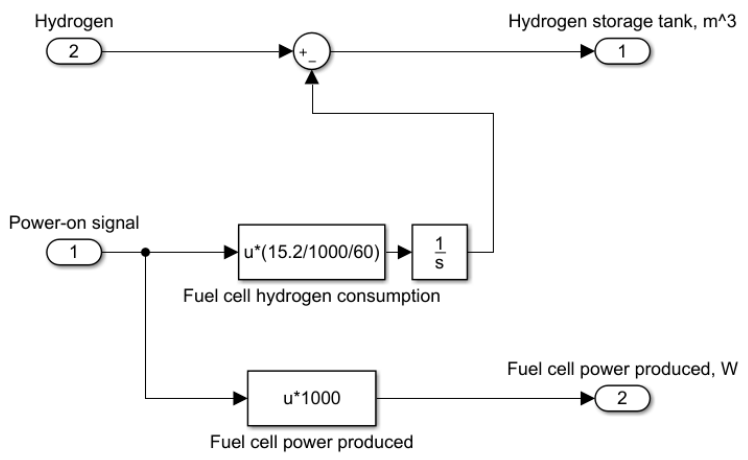
Figure 12. Hydrogen production and pumping for fuel cell operation.